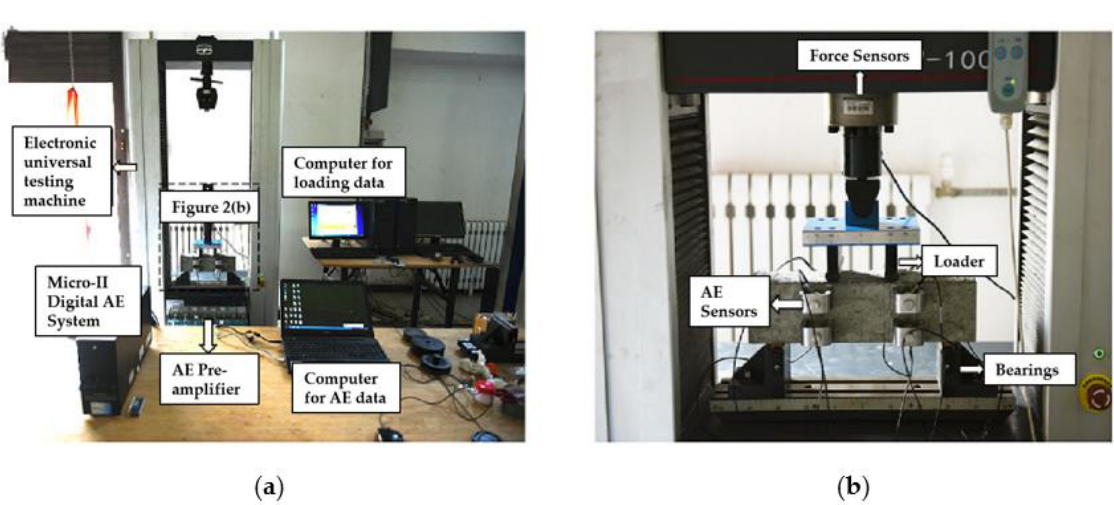
Figure 2. ( a ) AE experimental equipment and ( b ) labeled image of the four-point bending test. Table 2. Information on test apparatus.